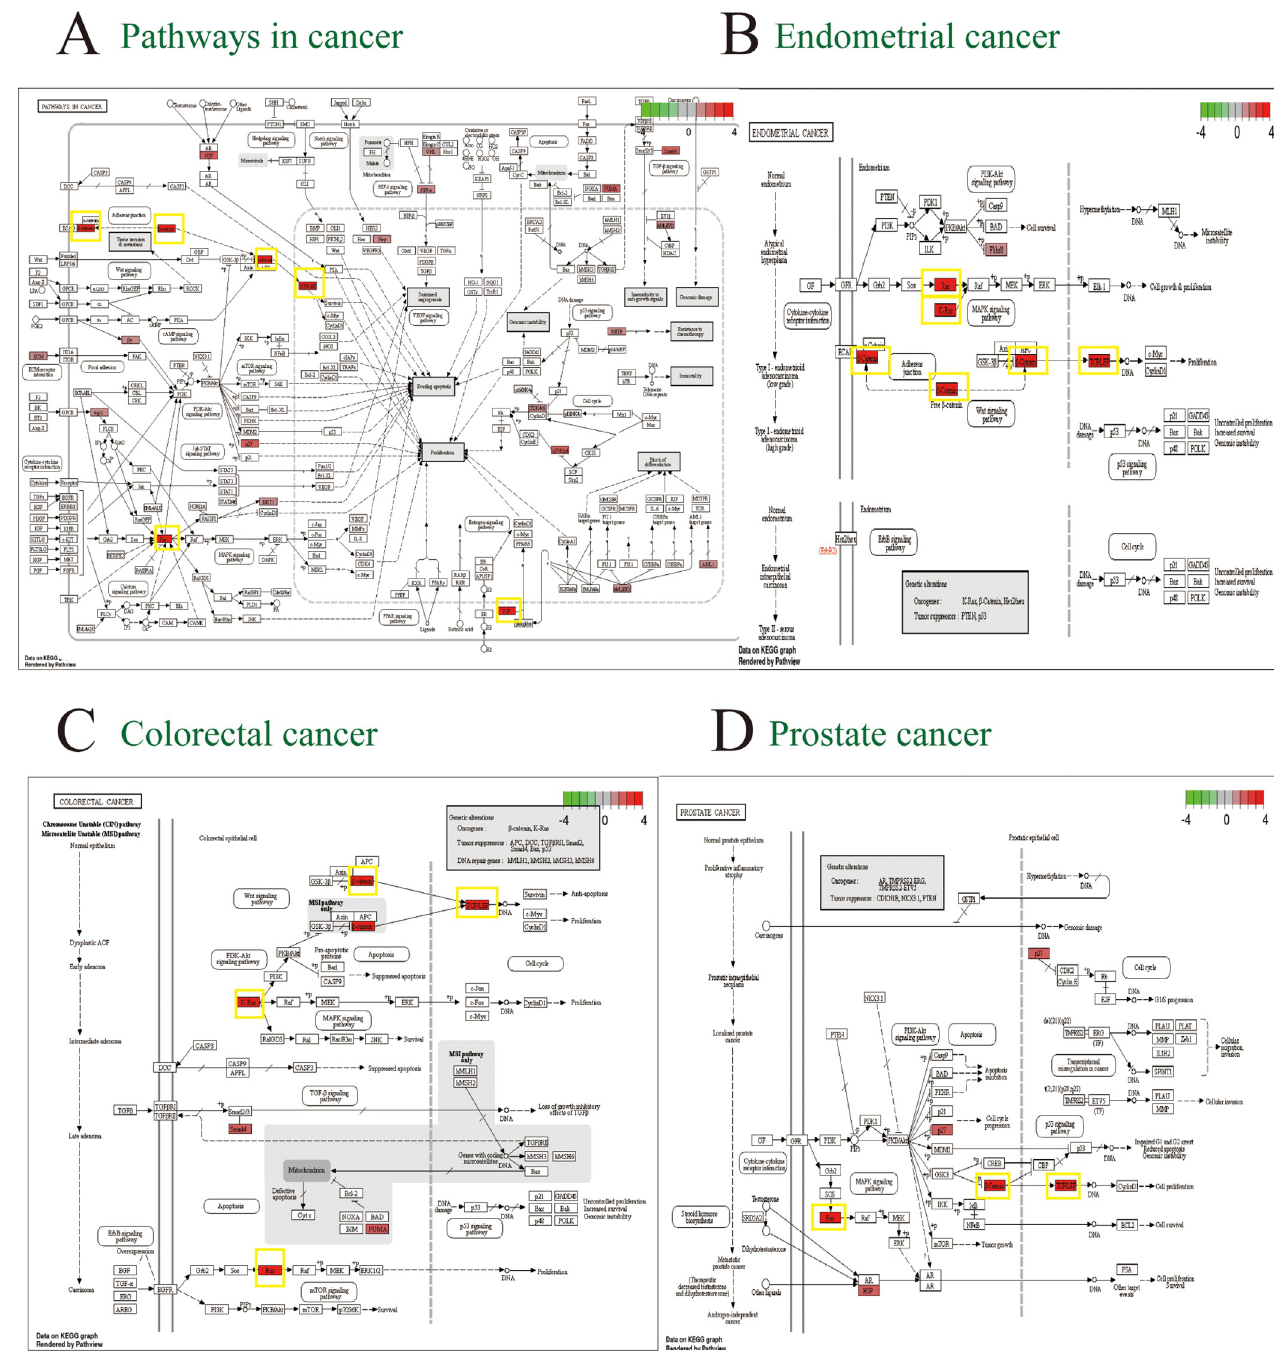
Fig 7. Kyoto encyclopedia of genes and genomes (KEGG) signaling pathway map. Red indicates genes that are enriched in cancer signaling pathways. The four genes, TCF7L2, NRAS, CTNNB1, and KRAS, framed in yellow are jointly enriched by these two pathways and are mainly involved in cell proliferation.